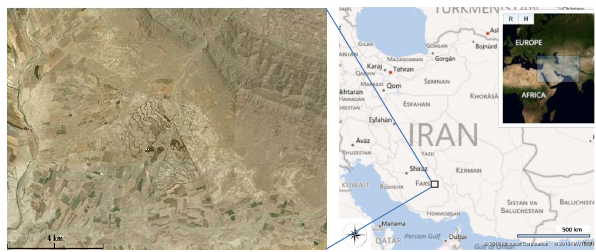
Fig. 1. Map of Iran and location of study area.